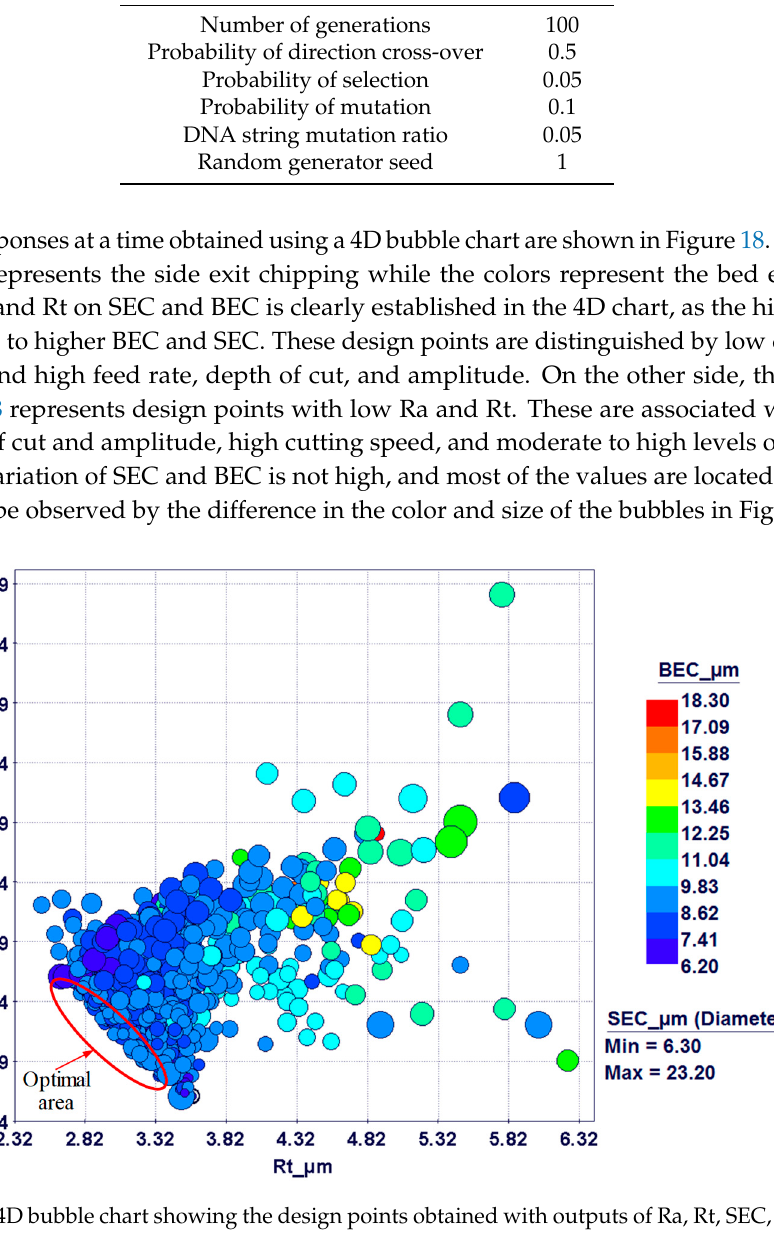
Figure 18. A 4D bubble chart showing the design points obtained with outputs of Ra, Rt, SEC, and